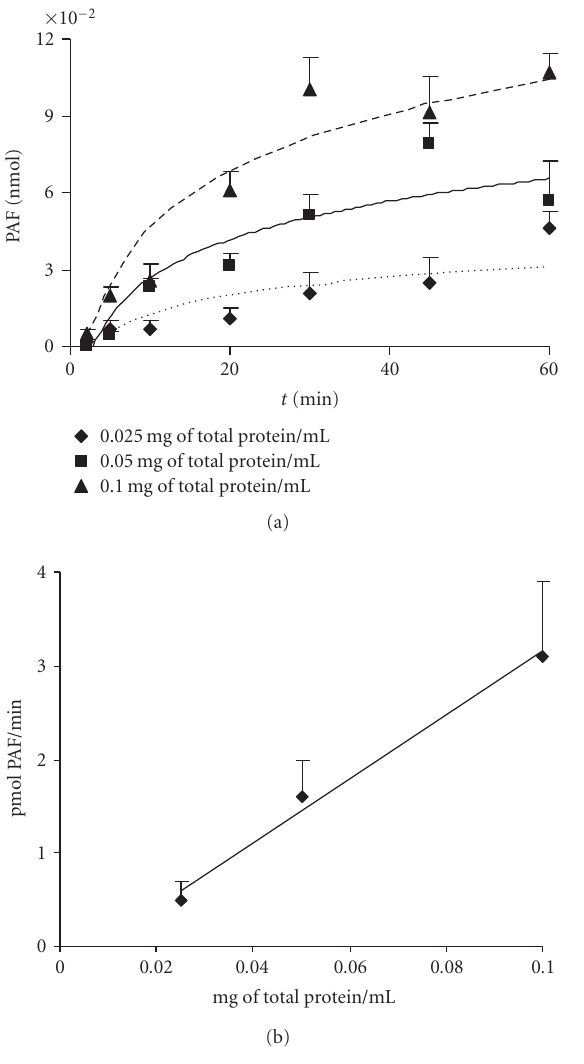
Figure 5: Dependence of PAF formation on incubation time and protein concentration: (a) time course of PAF production using 0.025, 0.05, and 0.1 mg total protein/mL; (b) CPT activity as a func- tion of protein concentration at a fixed incubation time of 20 min- utes. Experiments were performed with microsomal fractions of HMC in the presence of 100 μ M AAG and 100 μ M CDP-choline. Results are the average of two independent determinations using di ff erent enzyme preparations performing duplicate samples.